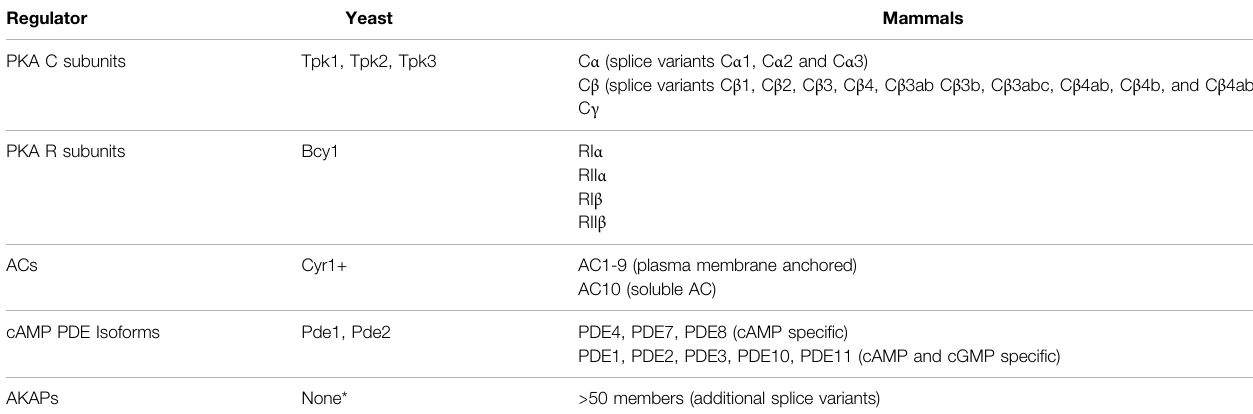
TABLE1| PKAsubunitsandmajorPKAregulatoryproteins.KnownPKAplayersinbuddingyeast S.cerevisiae andmammaliansystems.Seetextforreferences.+Cyr1can localize to multiple membranes including in the mitochondria, ER, and plasma membrane (Belotti et al., 2012). * Yeast cells lack proteins orthologs to AKAPs but have other proteins that may serve similar roles, see text for